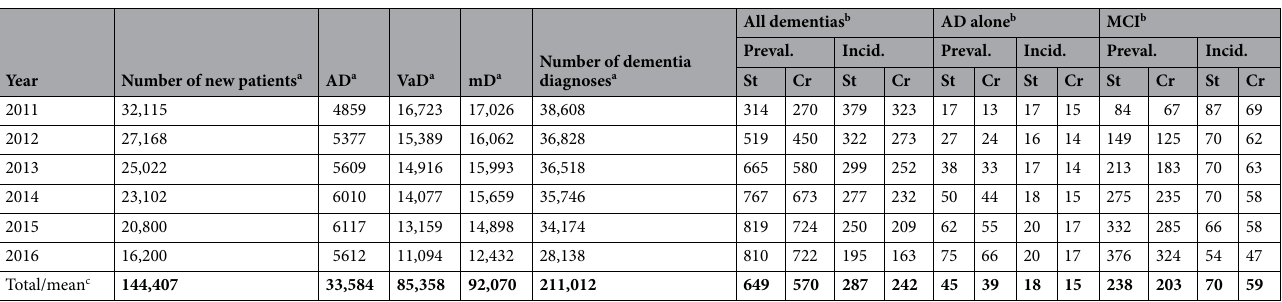
Table 1. Summary of number, prevalence and incidence data of patients and dementia types between 2011 and 2016. a Number of new patients and types of dementia. The date of the first diagnosis of any dementia type given to a patient was used for new patients; patients having more than one diagnosis were not defined as new patients when their diagnosis changed. b Incidence (new patients per 100,000 inhabitants/year) and prevalence (number of patients per 100,000 inhabitants) of all types of dementia, AD alone (without the mixed cases) and MCI in Hungary between 2011 and 2016. Age standardization was performed using the 2013 European standard population 8 . Incid. incidence, Preval. prevalence, Cr crude, St standardized. c The total numbers in case of a columns and the mean values of incidences and